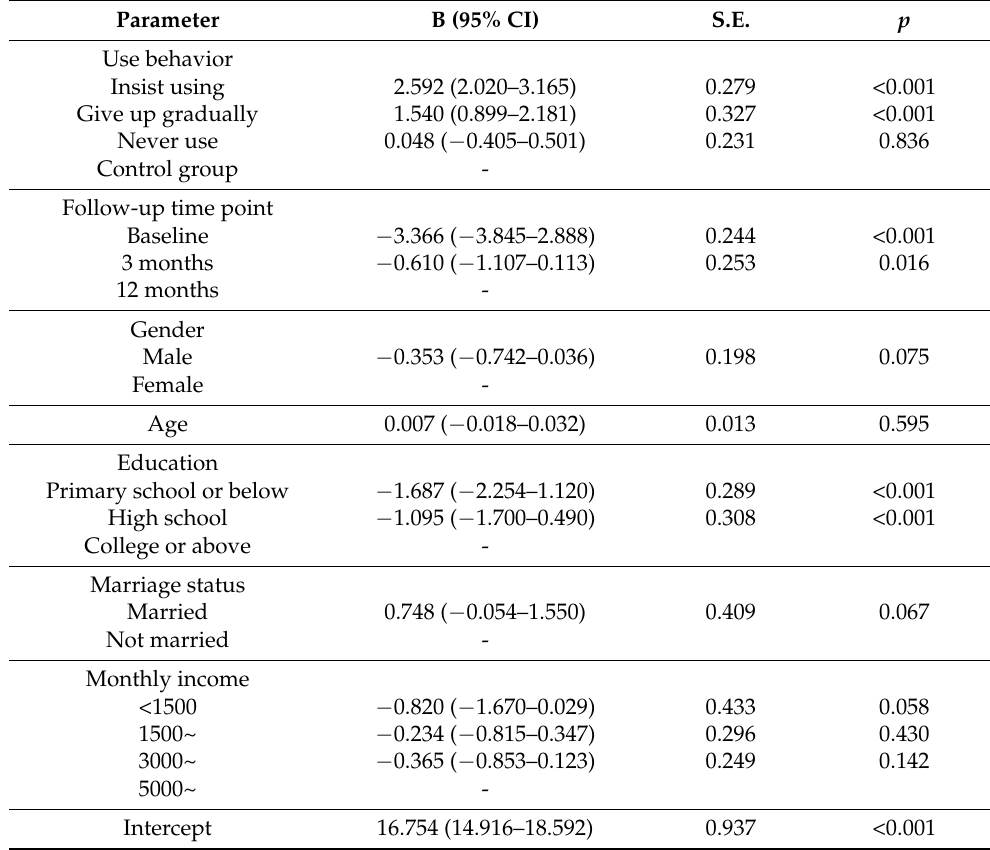
Table 4. The influence of the dinner set use on dietary